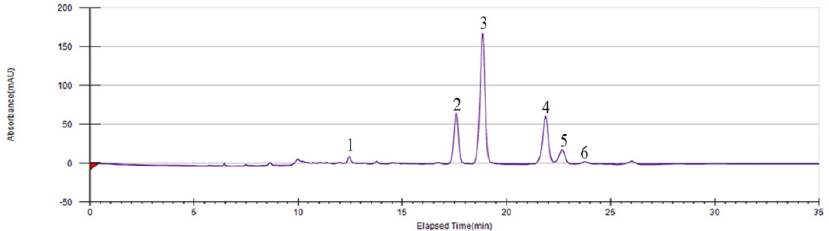
Figure 1. Isolation and preparation of the six main compounds in Smilax glabra flavonoids extract (SGF) by preparative high-performance liquid chromatography (PHPLC).